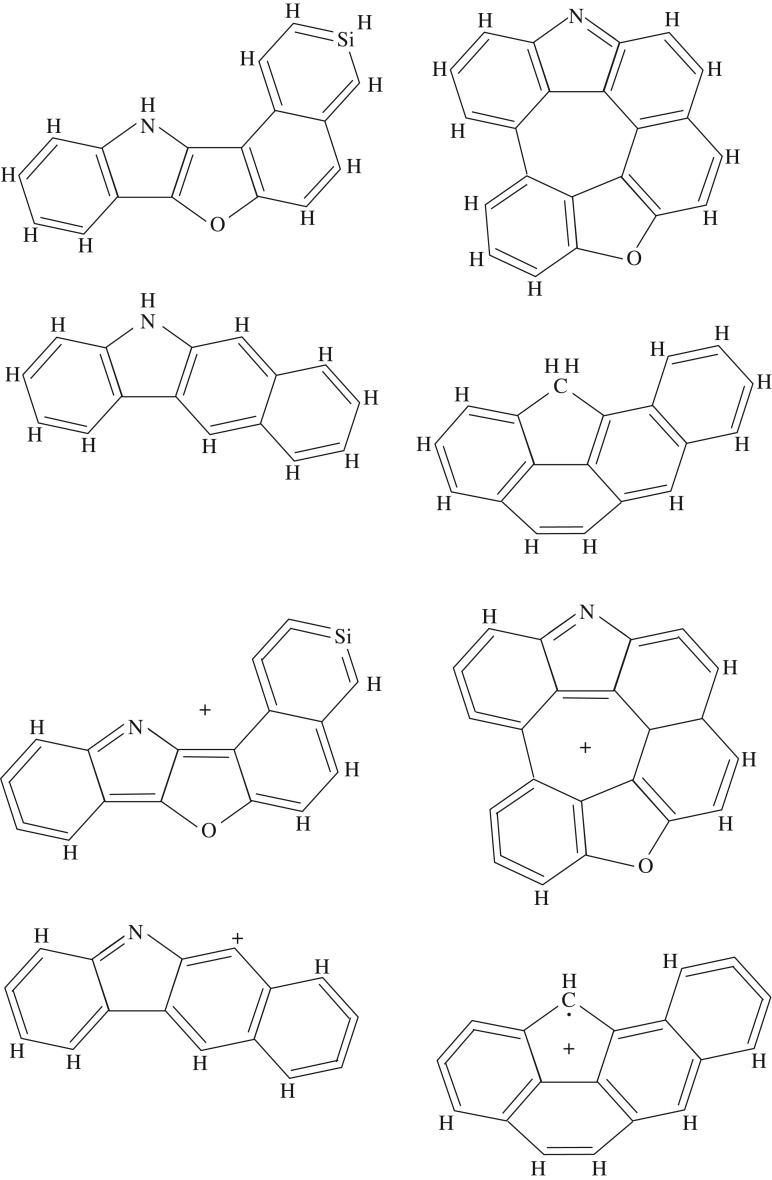
Four likely DIB precursor molecules, with 17–24 heavy atoms and the following structures S2POPNS, S2POSGSPN, S4P′ and S2PNS. The lower part of the figure shows their ionized and ≈50% dehydrogenated forms, 〈H]S2POPNS+, 〈H]S2POSGSPN+, 〈H]S4P′+ and 〈H]S2PNS+: such polycyclic, hetero-cyclic, radical cations could be candidate DIB carriers.